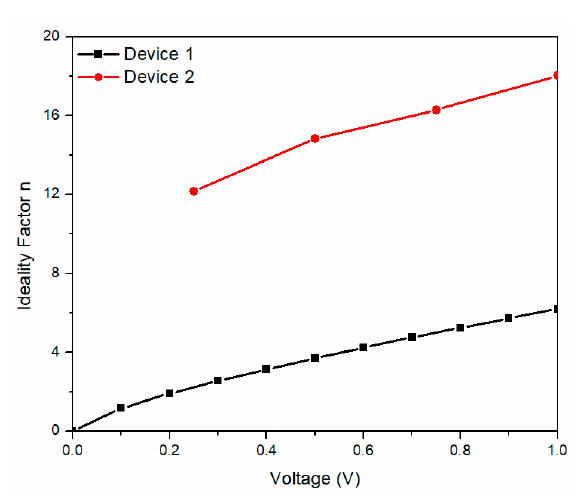
Figure 6. Voltage-dependent ideality factor of the devices.